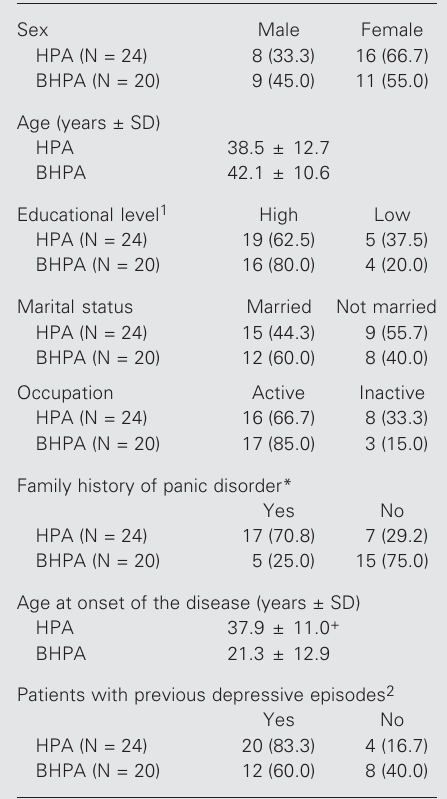
Table 1. Demographic and clinical characteristics of the hyperventilation-sensitive panic attack group (HPA) vs the breath-holding-sensitive panic attack group